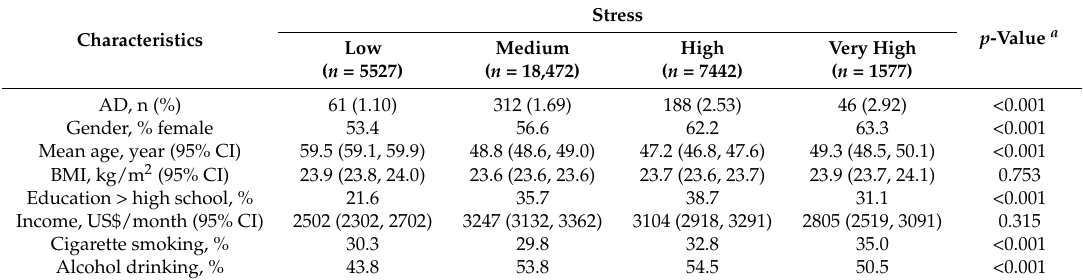
Table 2. Demographic characteristics by categories of self-reported